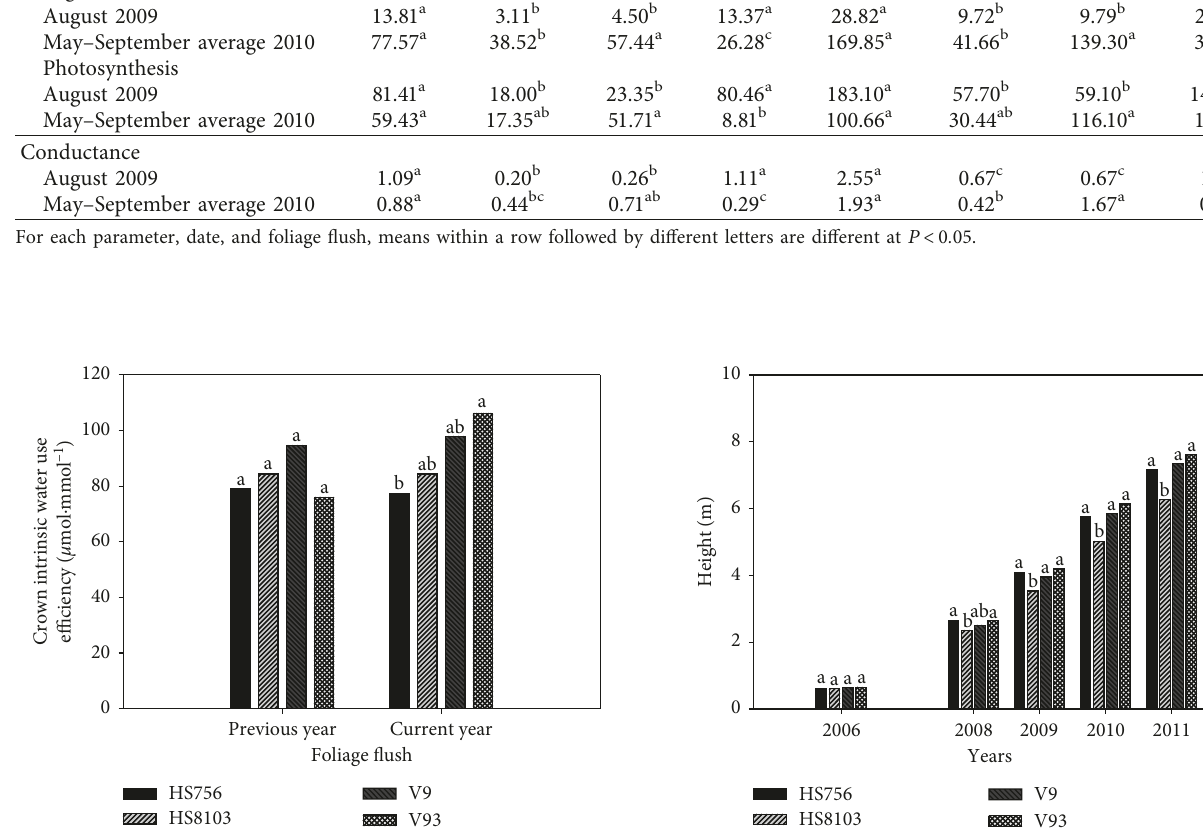
Figure 3: Tree height of loblolly pine genotypes from the eastern portion of the species’ range grown at a site in North Central Louisiana.